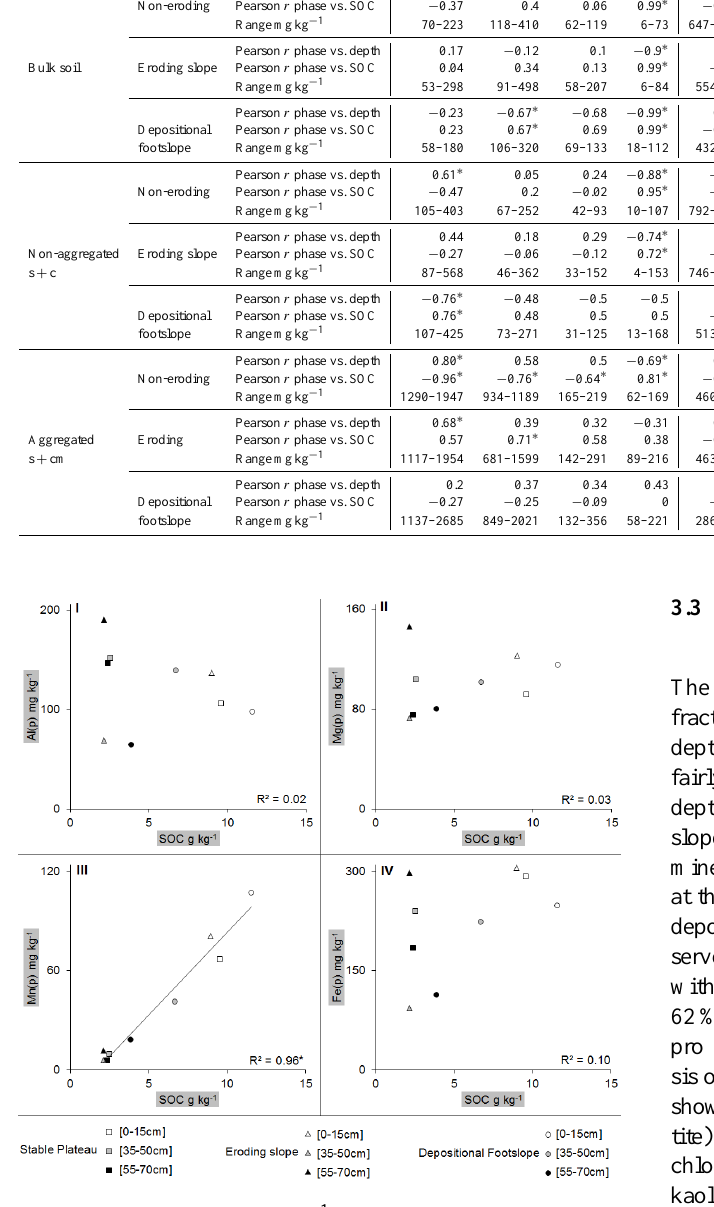
Figure 3. Mean SOC (g kgsoil − 1 ) and pyrophosphate extractable Al (I), Mg (II), Mn (III), and Fe